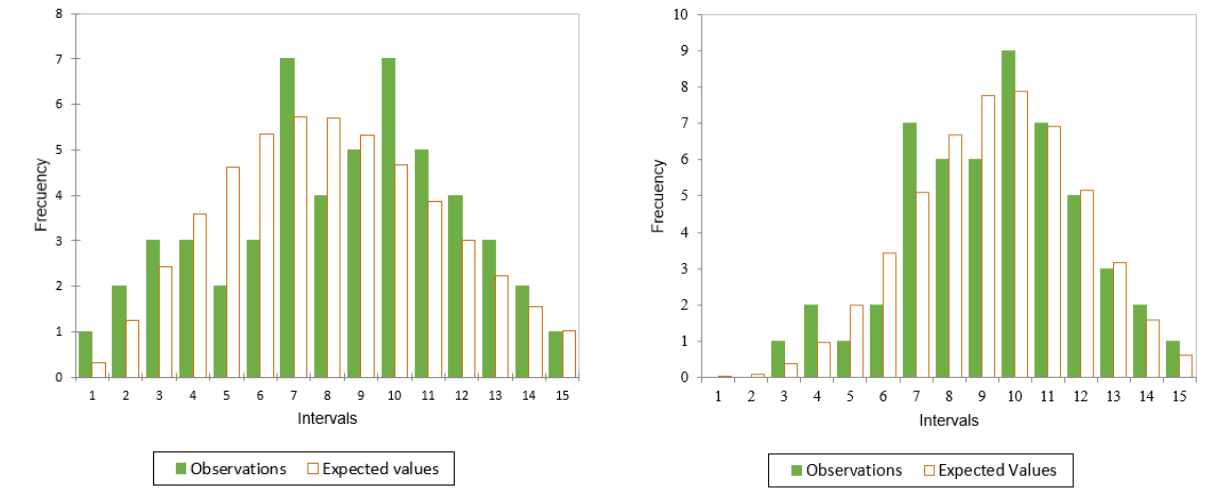
Figure 3. Comparison of the distributions for the ultimate axial force ( F u ) and the intrinsic ultimate force ( F ∗ u ).